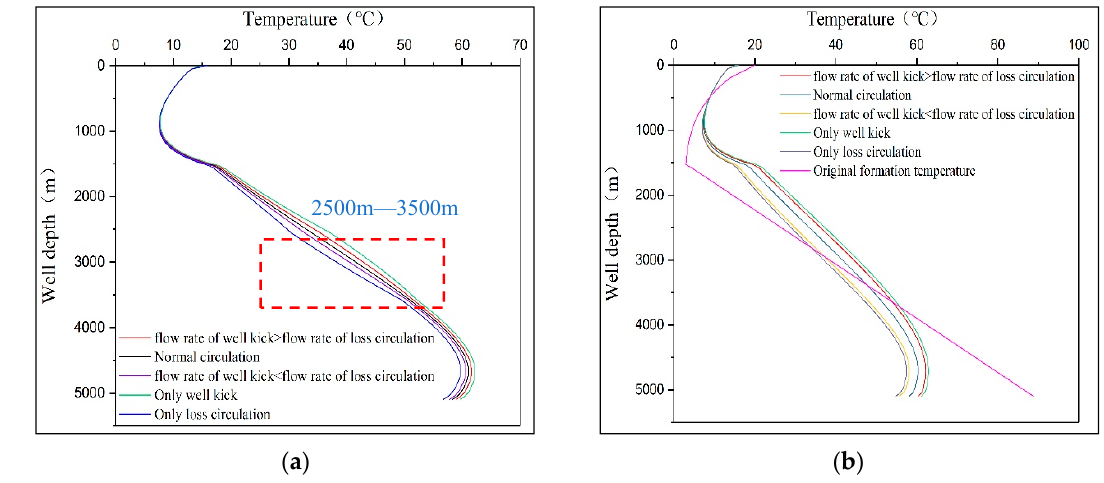
Figure 8. Annulus temperature distribution under multi-pressure system, only overflow or only leakage; ( a , b ) show conditions when the multi-pressure system is located in middle formation and at bottom hole, respectively.